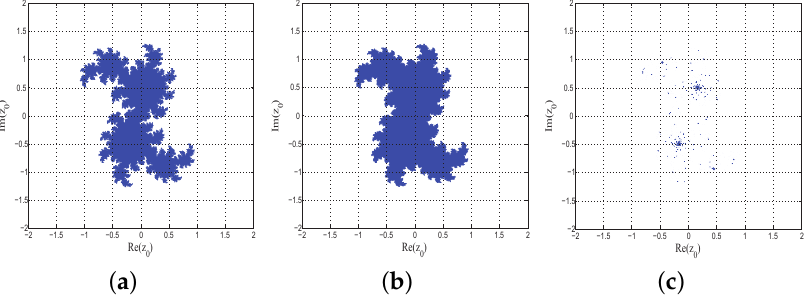
) 1 = 0.40 + 0.35 i , c 2 = 0.39 + 0.32 i